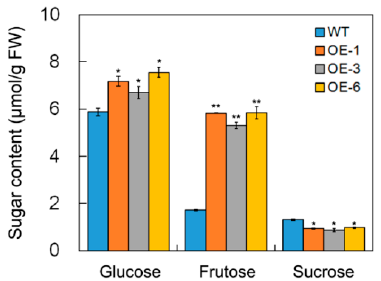
Figure 6. Sugar content in wild type (WT) and DsSWEET17 transgenic Arabidopsis (OE-1, OE-3, and OE-6) seedlings. The sucrose, fructose, and glucose contents were measured in seedlings grown on 1/2 Murashige and Skoog’s (MS) medium (3% sucrose) for 3 weeks. Asterisks indicate significant differences between WT and transgenic lines (* p < 0.05; ** p < 0.01; Student’s t test). Error bars show SD of the values from three replicates.